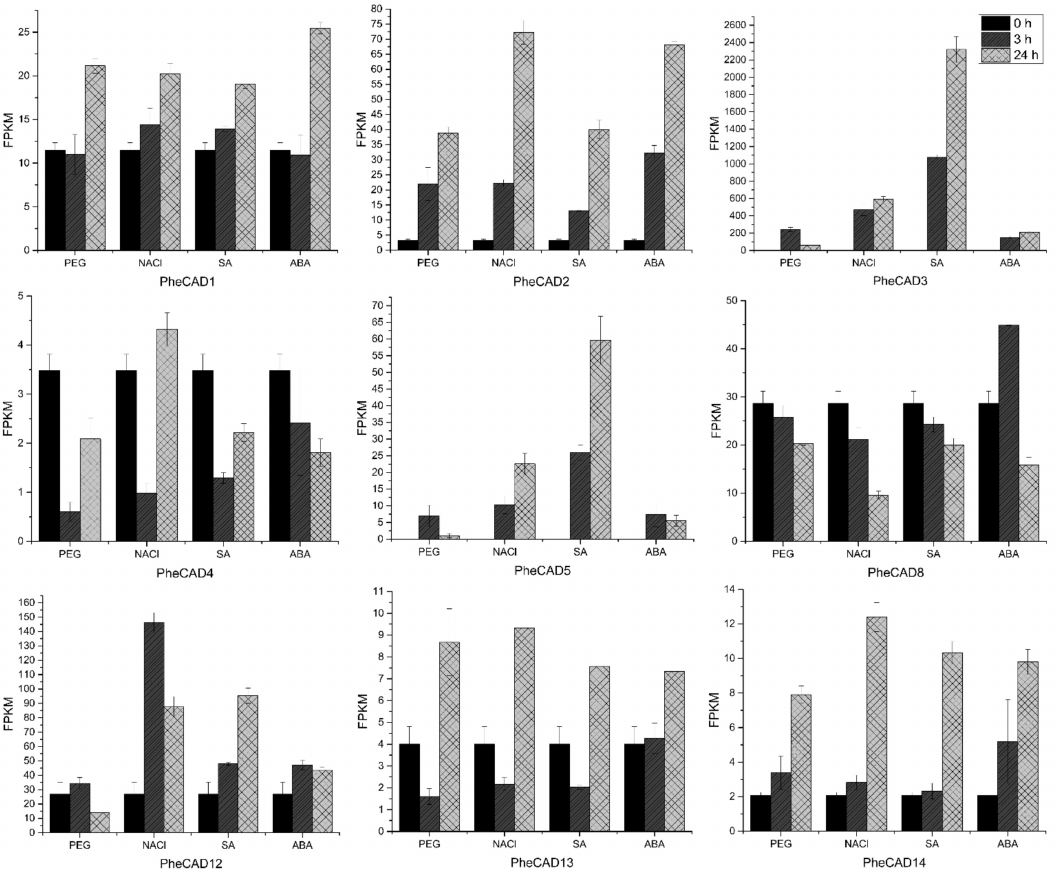
Figure 5. Expression analysis of PheCAD genes in response to PEG, NaCl, ABA and SA. The FPKM values of transcriptomic data (Moso bamboo seedlings treated with PEG (25%), NaCl (200mM), ABA (1uM), SA (1mM) for 3 and 24 h) were used to develop